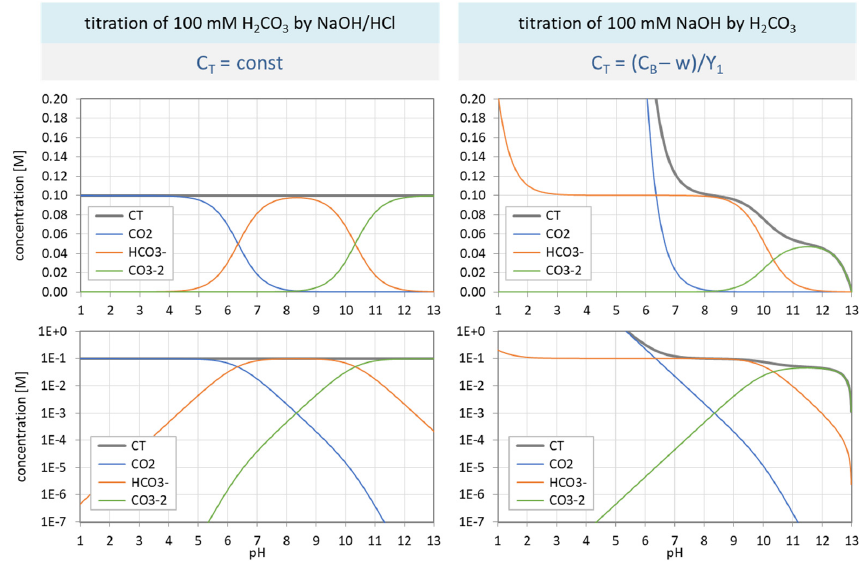
Figure 31. Species distribution of H 2 CO 3 as a function of pH for var A ( left ) and var B ( right ). Top diagrams: concentrations in linear scale; bottom diagrams: logarithmic scale.